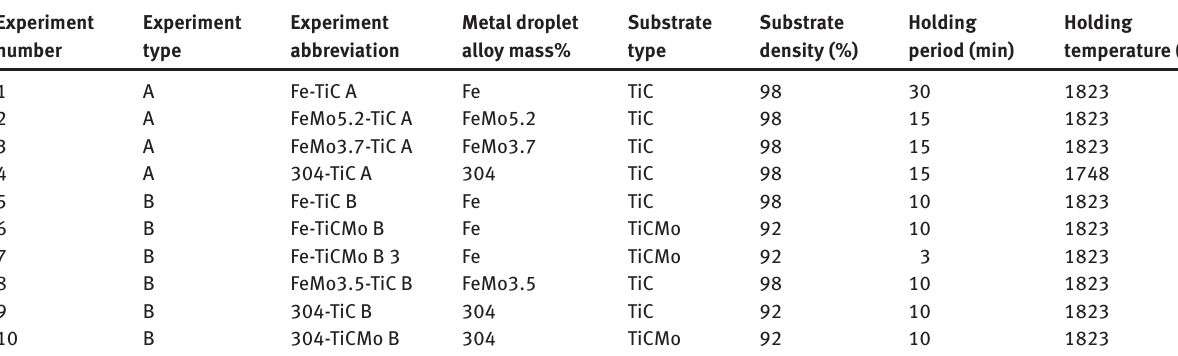
Table 1: Summary of the experiments Experiment